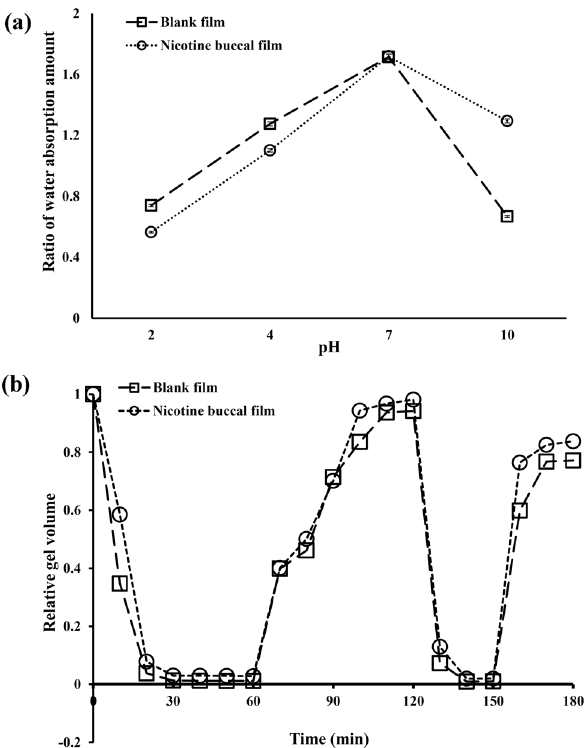
Figure 2: ( a ) Ratio of water absorption amount at di ff erent pH values and ( b ) relative gel volume of blank and nicotine buccal fi lms.